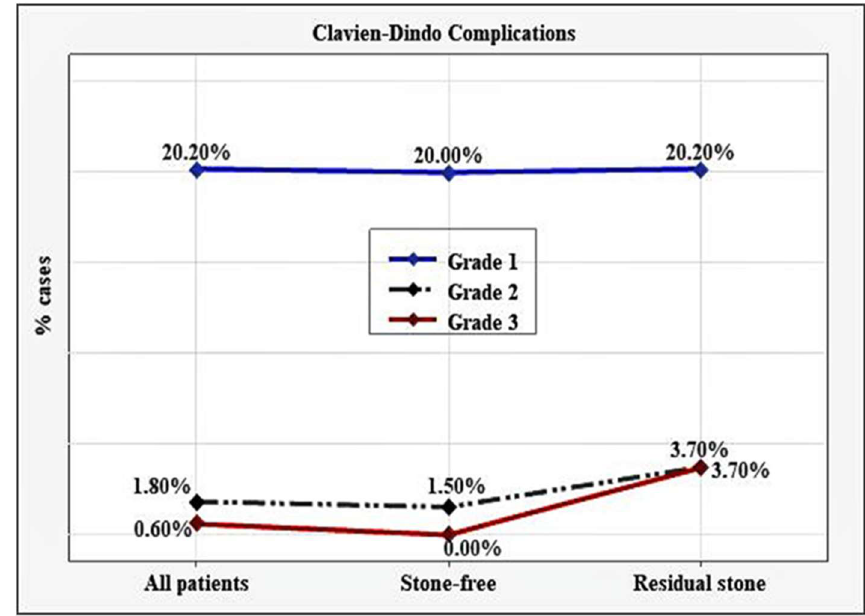
Figure 3. Postoperative complications on the Clavien-Dindo